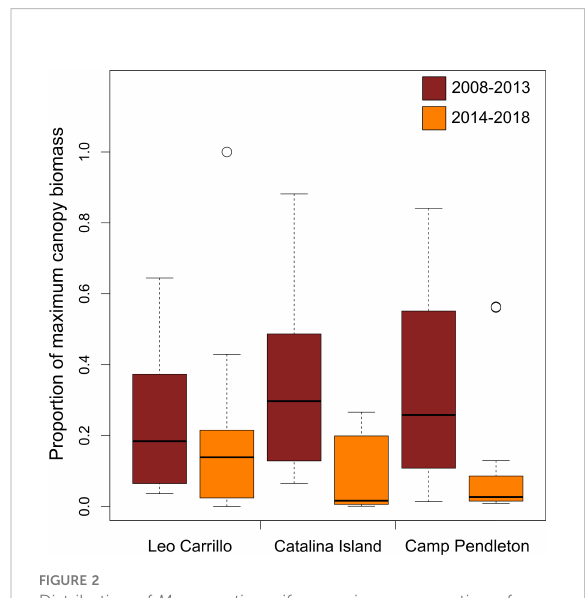
FIGURE 2 Distribution of Macrocystis pyrifera maximum proportion of biomass observed per quarter. Two boxplots shown for each population showing pre- (brick color) or post-disturbance periods (orange